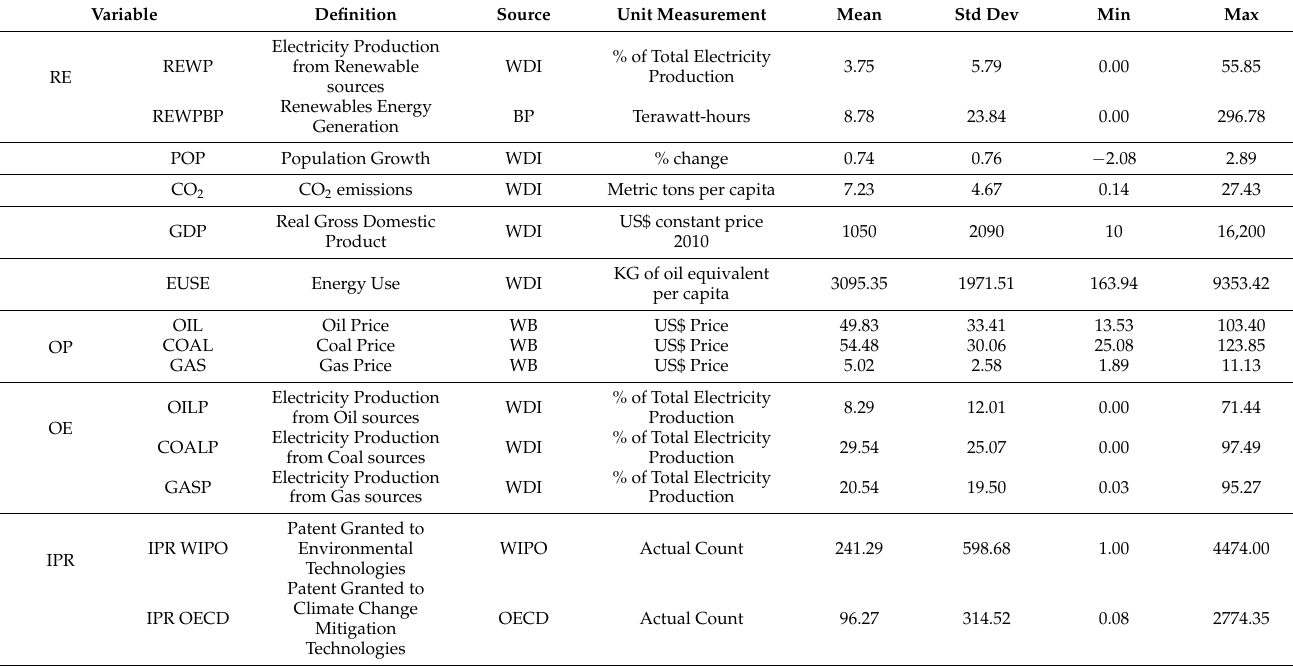
Table A2. Definitions, data sources, and